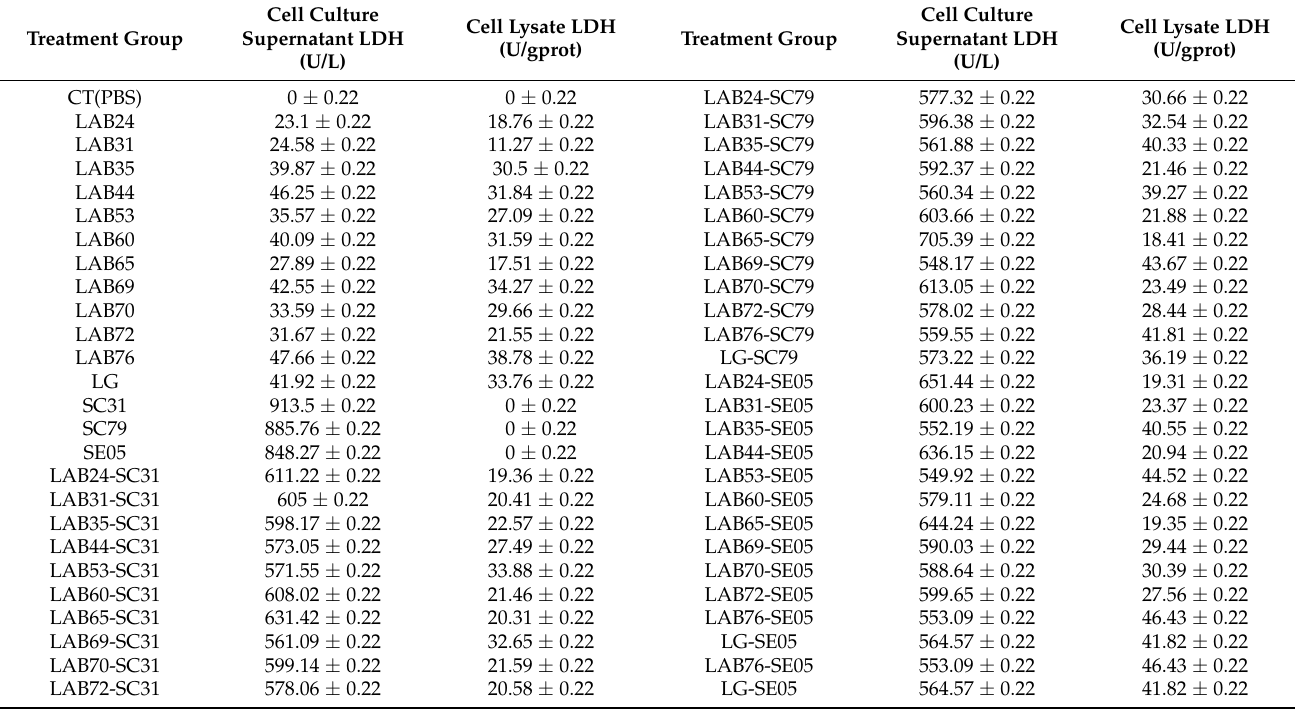
Table 4. Lactate dehydrogenase (LDH) activity in lysate and supernatant of Caco-2 cells incubated with 12 strains of Lactobacillus and 3 strains of